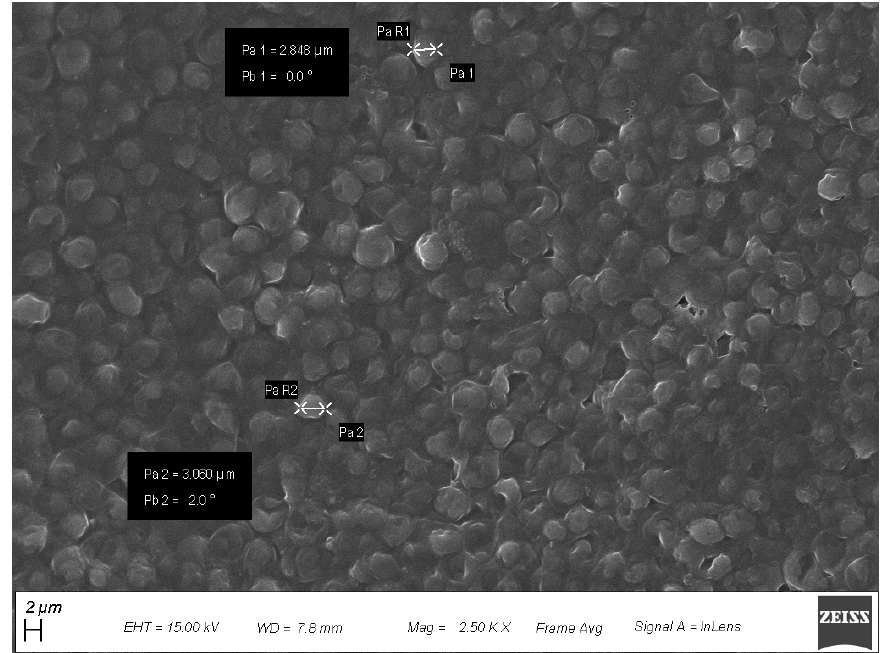
Figure 6. Yeast cells size measurement by SEM analysis of NWLs. Table 6. Different size measured at the DLS between yeast cells of native, sonicated and lyophilized lees